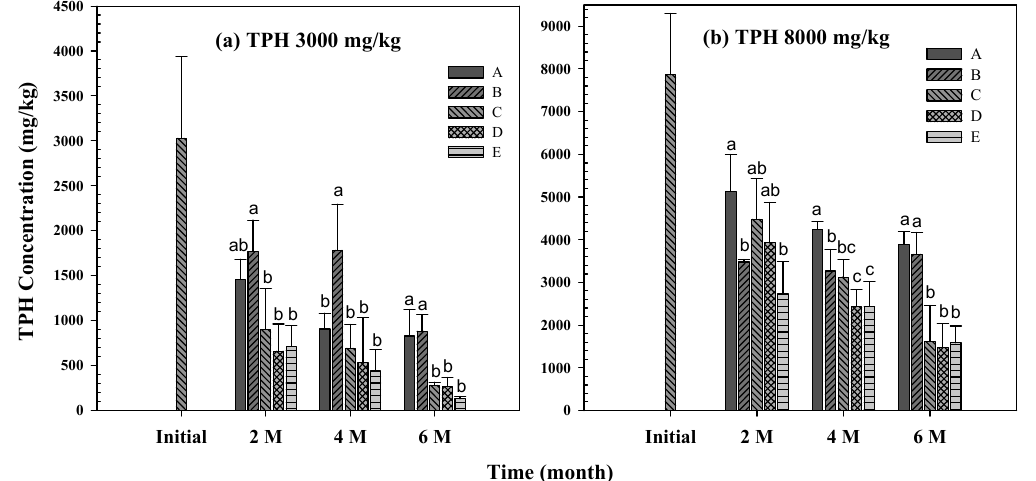
Figure 2. Changes of TPH concentration in different bioremediation test groups. ( a ) for initial soil TPH concentration was 3000 mg/kg; ( b ) for initial soil TPH concentration was 8000 mg/kg. “M” stands for test time (month). Identical lowercase letters on bar indicate statistically insignificant differences; differences indicate significant differences.